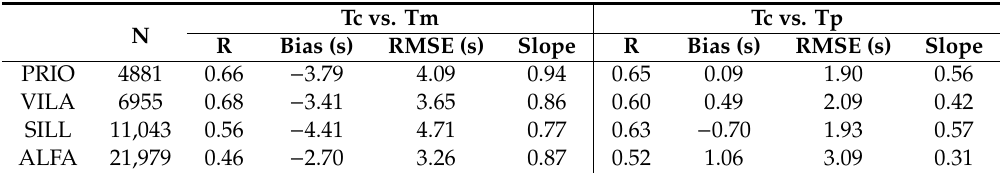
Table 4. Comparisons between buoy wave periods (Tp and Tm) and HFR Tc (36-months period). Statistics metrics: Correlation coefficient (R), RMSE, bias, SI, and slope. N corresponds to HFR & Buoy SWH observation pairs (hourly observations). Tc vs. N Tc vs. Tm Tc vs. Tp N Bias R